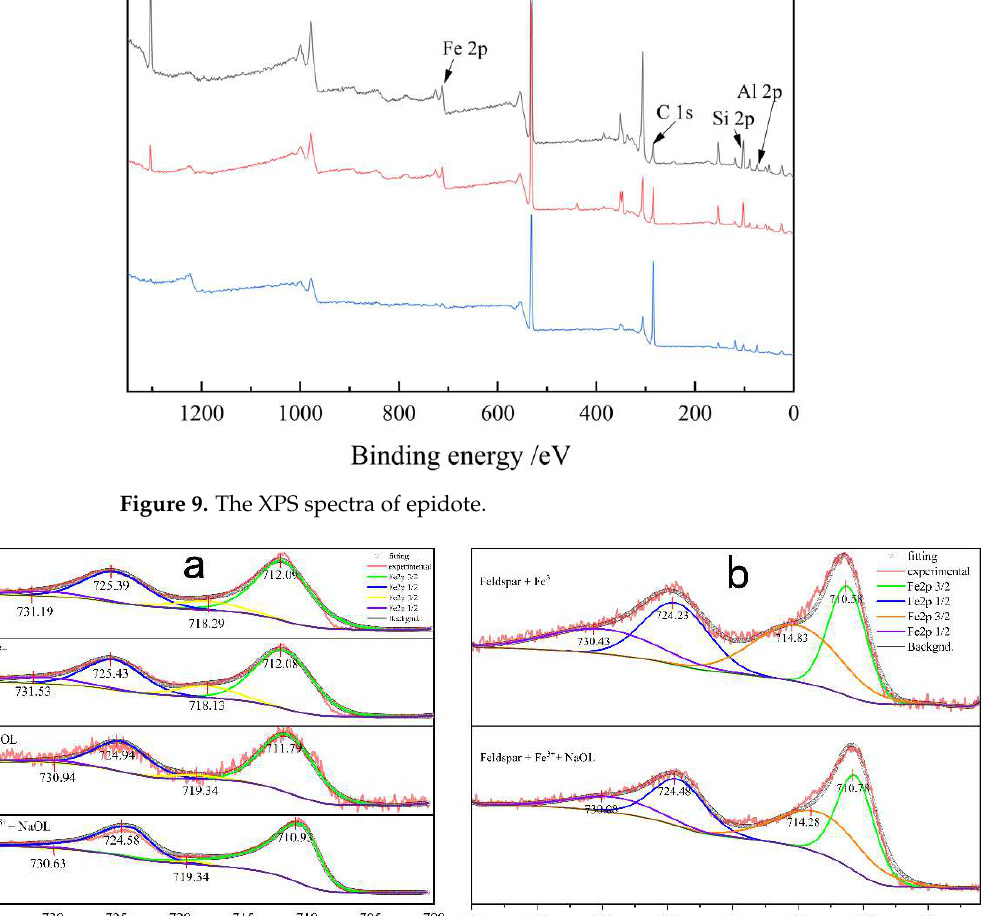
Figure 10. Narrow scan Fe2p spectra of ( a ) epidote and ( b ) feldspar at natural pH. Table 2. Binding Energy of Surface element Fractions.